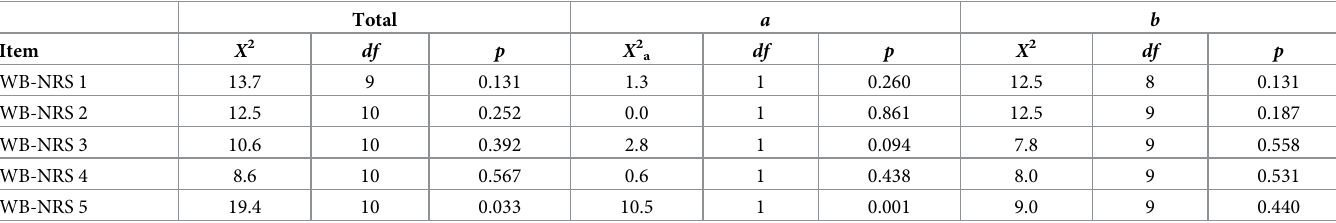
Table 7. Differential item functioning analyses of the Well-being Numerical Rating Scales (WB-NRSs) across Italian and Canadian samples. Total a b Item X 2 df